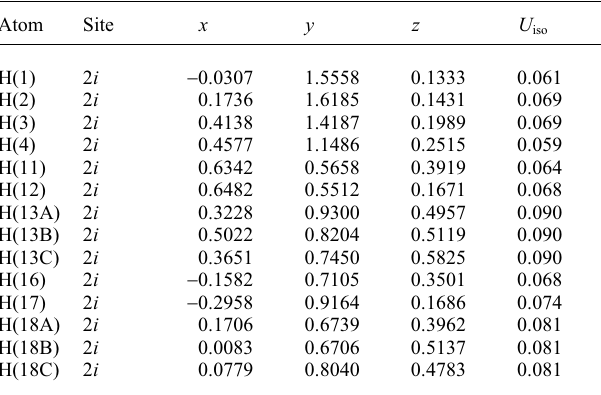
Table 2. Atomic coordinates and displacement parameters (in Å 2 ) .